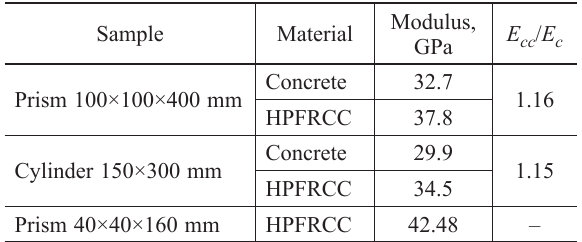
Table 4. Modulus of elasticity